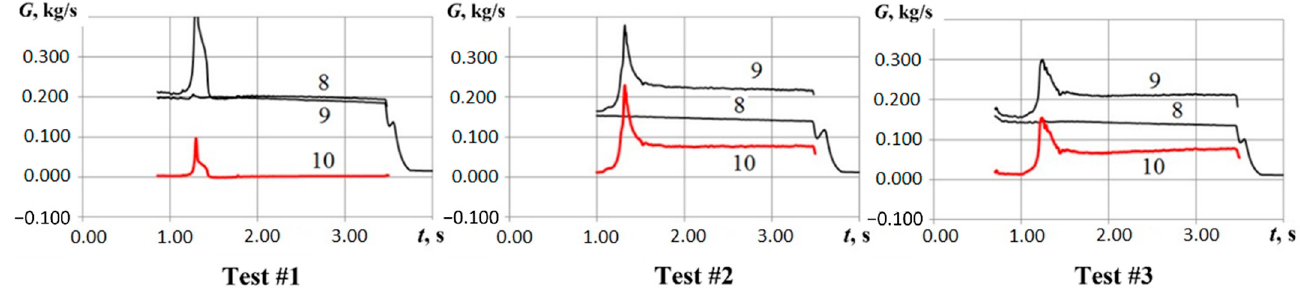
Figure 9. Calculated time histories of flow rates G in (curve 8), G out (9) and Δ G = G out ( t ) − G in ( t ) (10) at М 1 = 2.43 in tests 1 to 3.